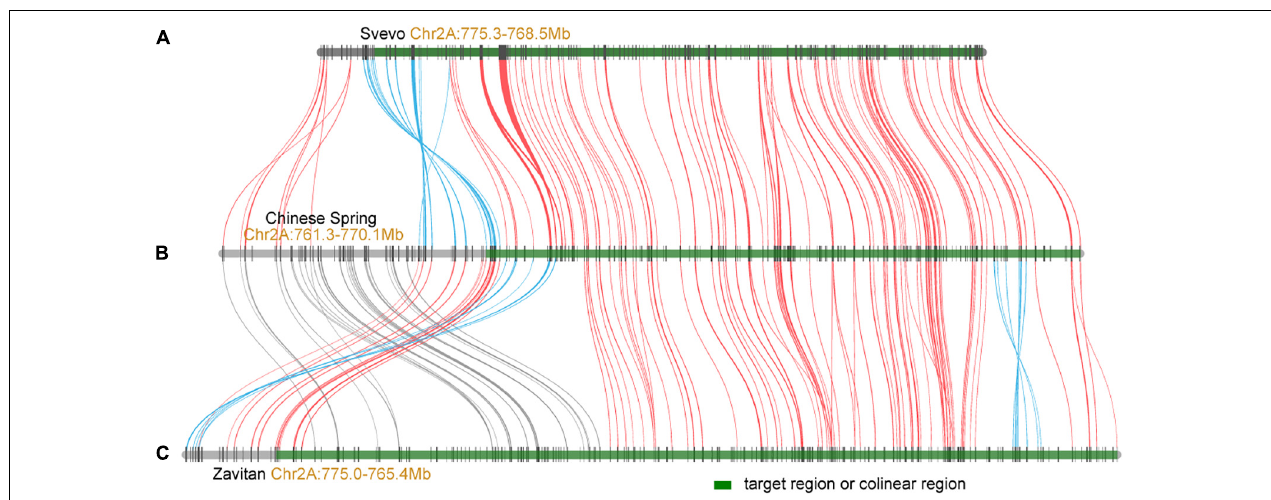
FIGURE 4 | Collinearity of Pm SN 15218 region between durum wheat Svevo (A) , common wheat Chinese Spring (B) , and wild emmer wheat Zavitan (C) . The green regions represent the colinear intervals of Pm SN 15218 gene.